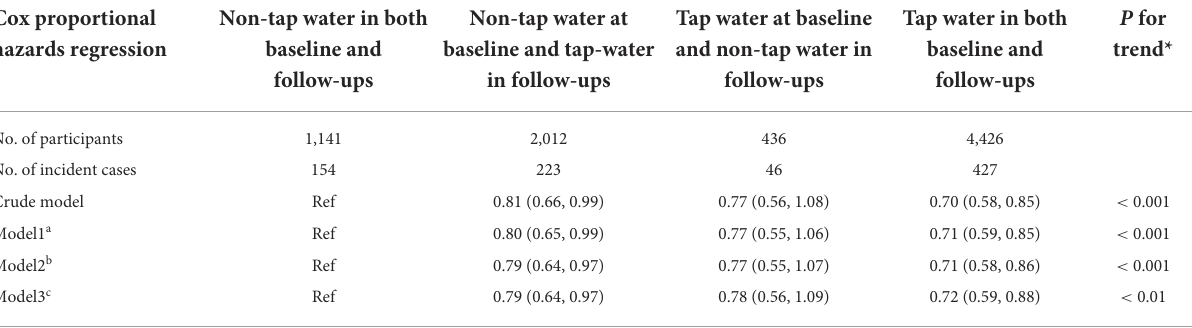
TABLE 3 Association between switching tap-water use and CGD. Cox